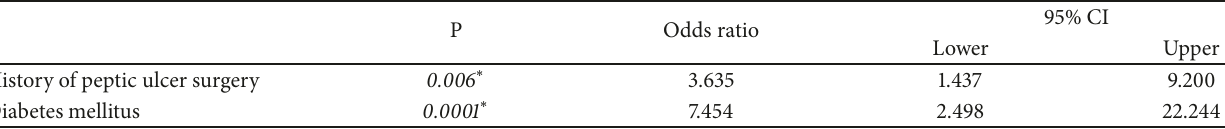
Table 4: Logistic regression analysis of risk factors effective in patients ≥ 65